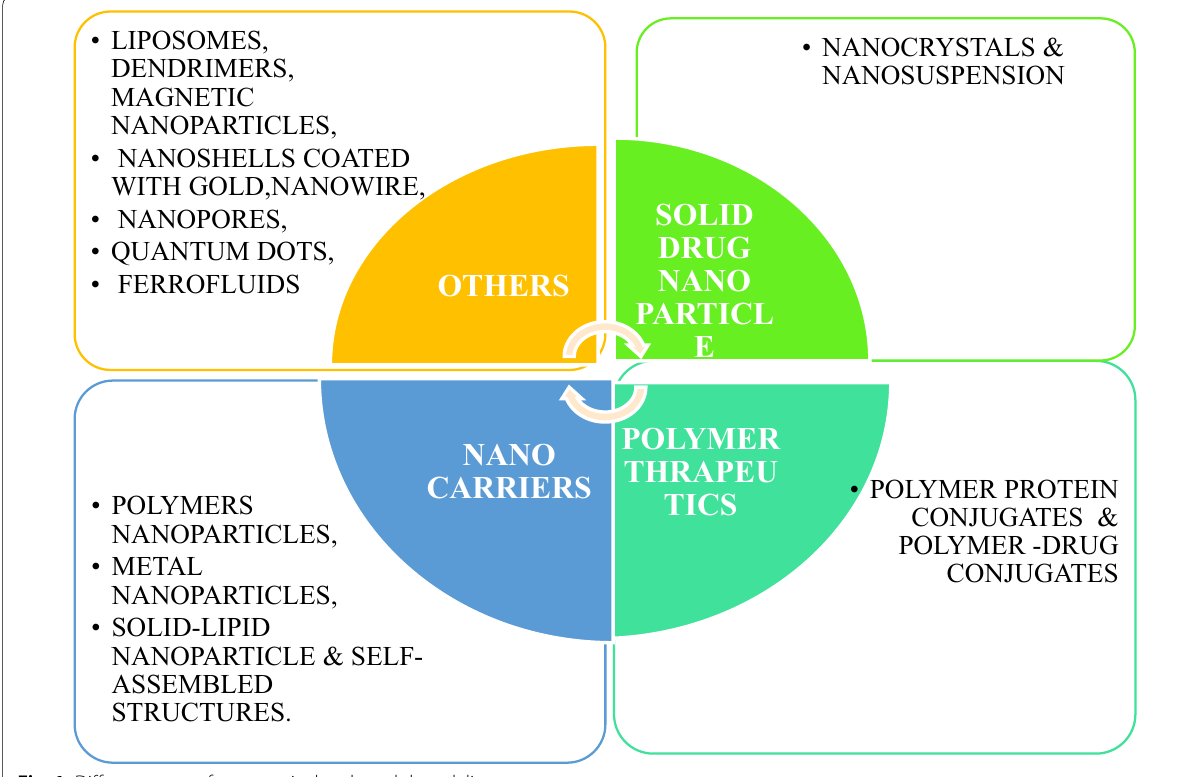
Fig. 1 Different types of nanoparticulate-based drug delivery